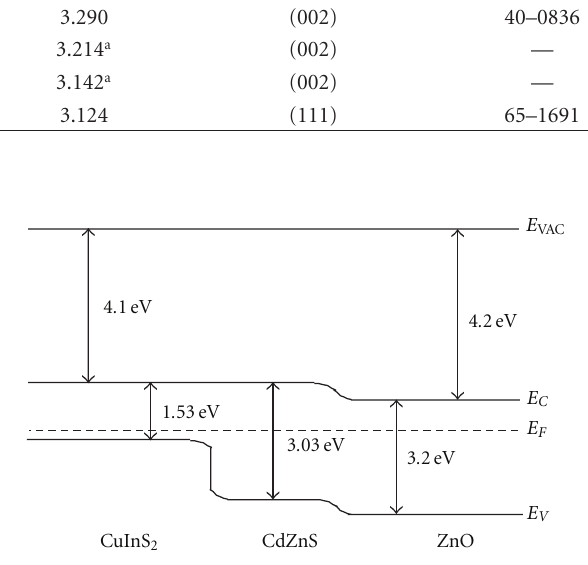
Figure 5: Flat band diagram of a CuInS 2 / ZnO heterojunction with a Cd 0 . 4 Zn 0 . 6 S bu ff er